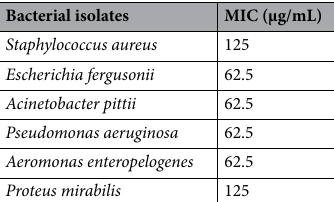
Table 5. Minimum inhibitory concentration (MIC) of PB-capped Pd-NPs.